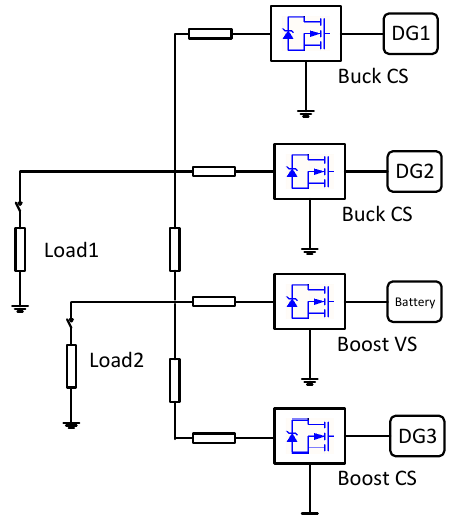
Figure 8. DC microgrid platform in real-time laboratory (RTlab) layout, where CS and VS mean the operating mode of current source and voltage source,